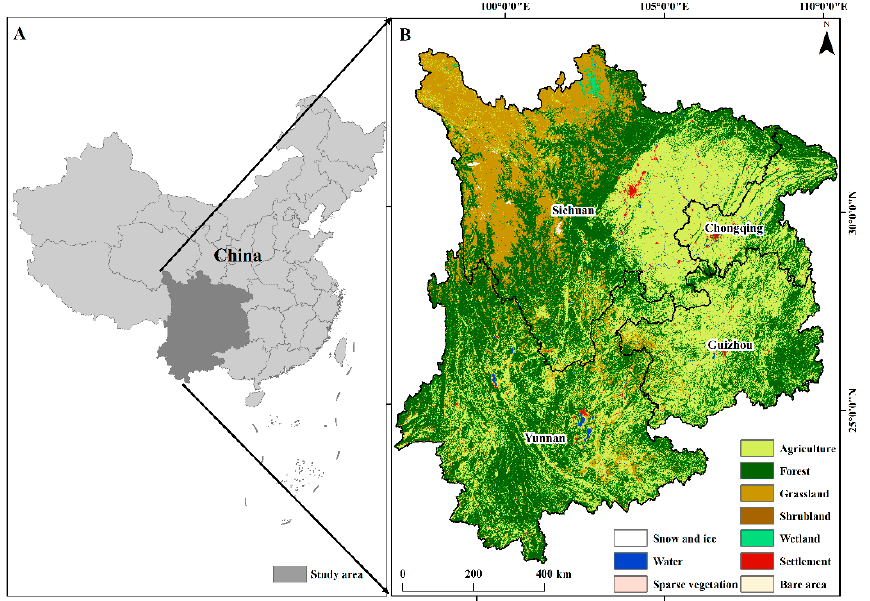
Figure 1. ( A ) Study area and ( B ) land CCI-LC in